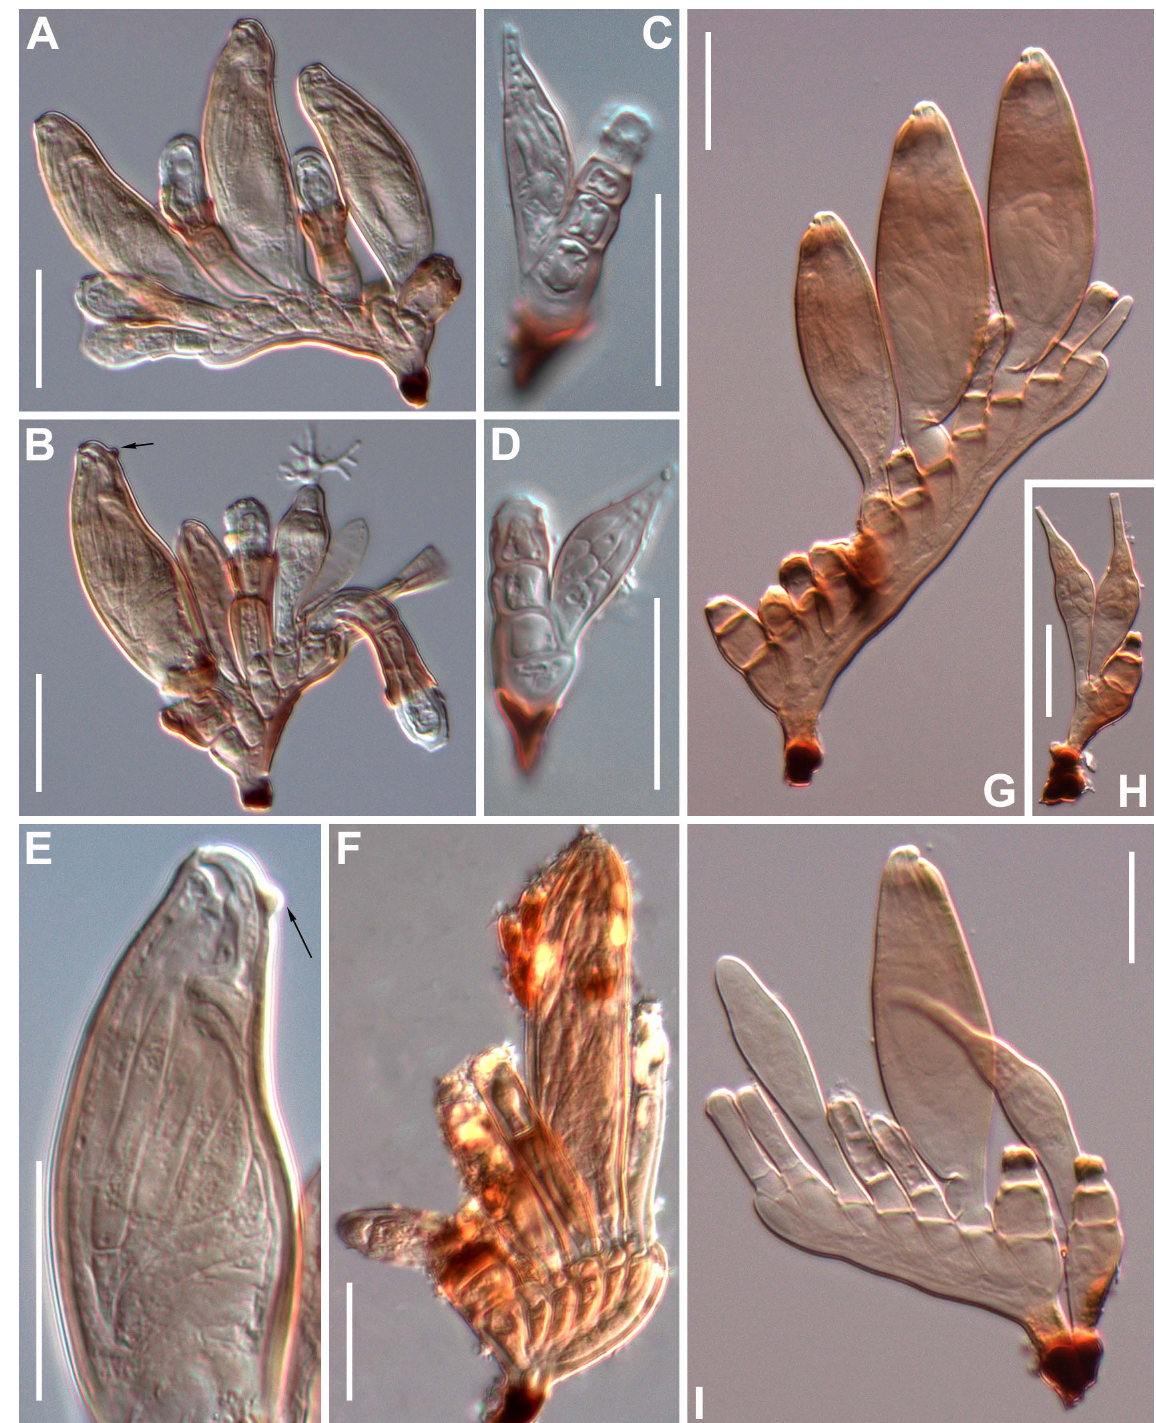
Fig. 73. Dimorphomyces spp. A – F . D. myrmedoniae Thaxt. A – B . Mature female thalli, showing perithecial outgrowth (arrow). C – D . Male thalli. E . Mature perithecium in detail showing perithecial outgrowth (arrow). F . Mature female thallus from type slide kept in FH. – G – I . D. phloeoporae Thaxt. G , I . Mature female thalli. H . Male thallus. Scale bars: A–B, F–I = 25 µm; C–E = 20 µm. Photographs from slides ZMUC C-F-123656 (A, C–D), ZMUC C-F-123657 (B, E), FH 00313727 (F) (type), ZMUC C-F-124218